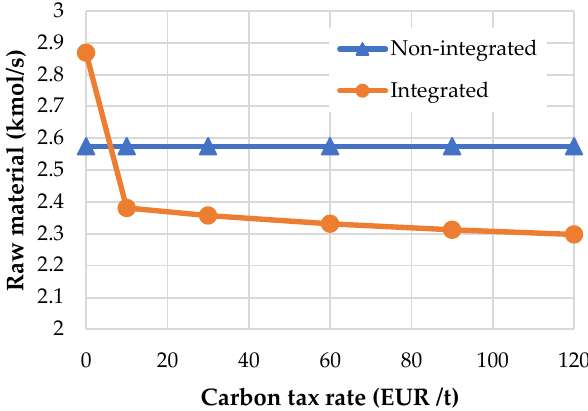
Figure 5. Raw material flow at different values of the CO 2 tax rate.